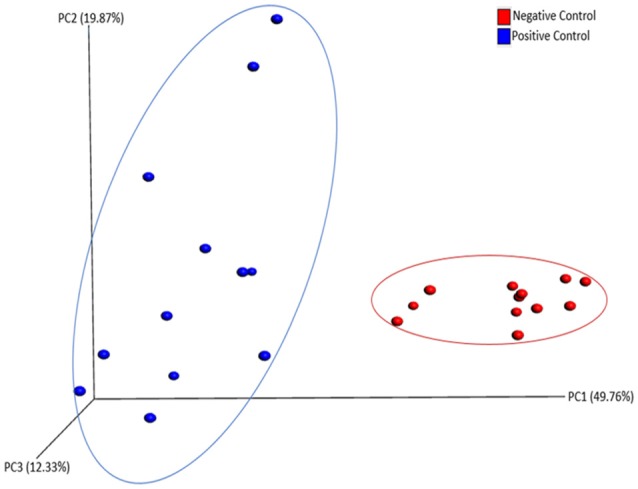
PCoA plot showing beta diversity between Negative and Positive control (with induced necrotic enteritis) as measured by weighted UniFrac metric. ANOSIM results (R = 0.76, P = 0.001) showed significant difference in community structure between groups.